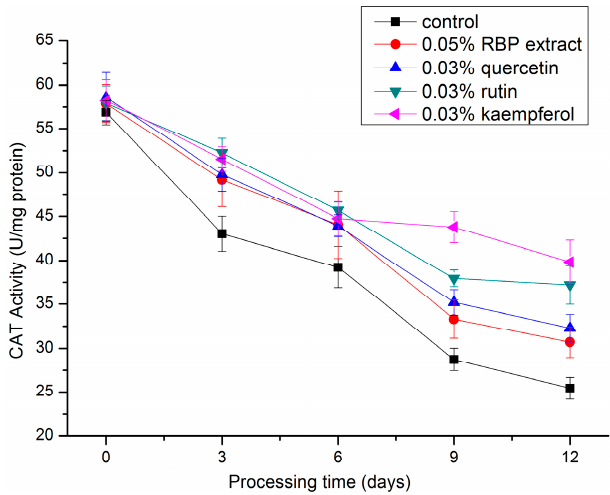
Figure 4. Changes in CAT activity during the processing of salami with different treatments.